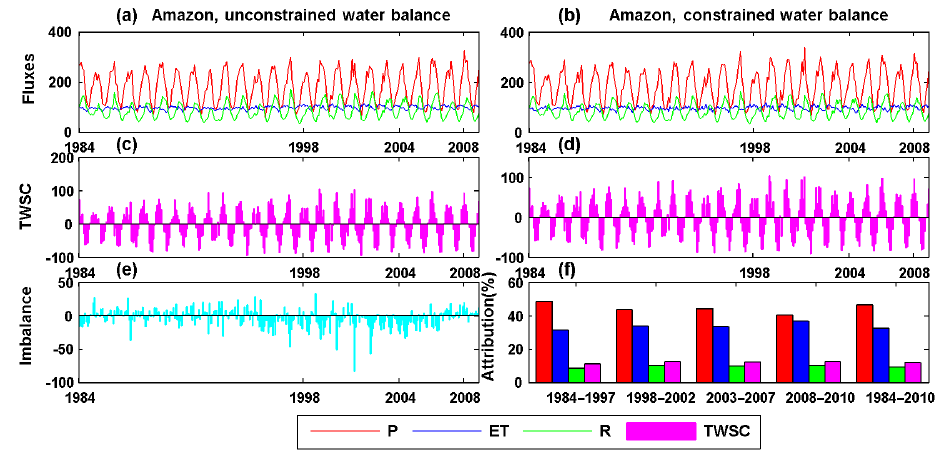
Figure 13. Unconstrained (a, c, e) and constrained (b, d) water budget estimates (mmmonth − 1 ) over the Amazon River basin. The top, middle, and bottom rows show the time series of water budget in terms of fluxes (precipitation, evapotranspiration, and runoff), TWSC, and imbalance. The imbalance/non-closure error after water budget constraint equals to zero and the imbalance/non-closure attributions to each water budget variables throughout different subperiods are shown in panel (f)